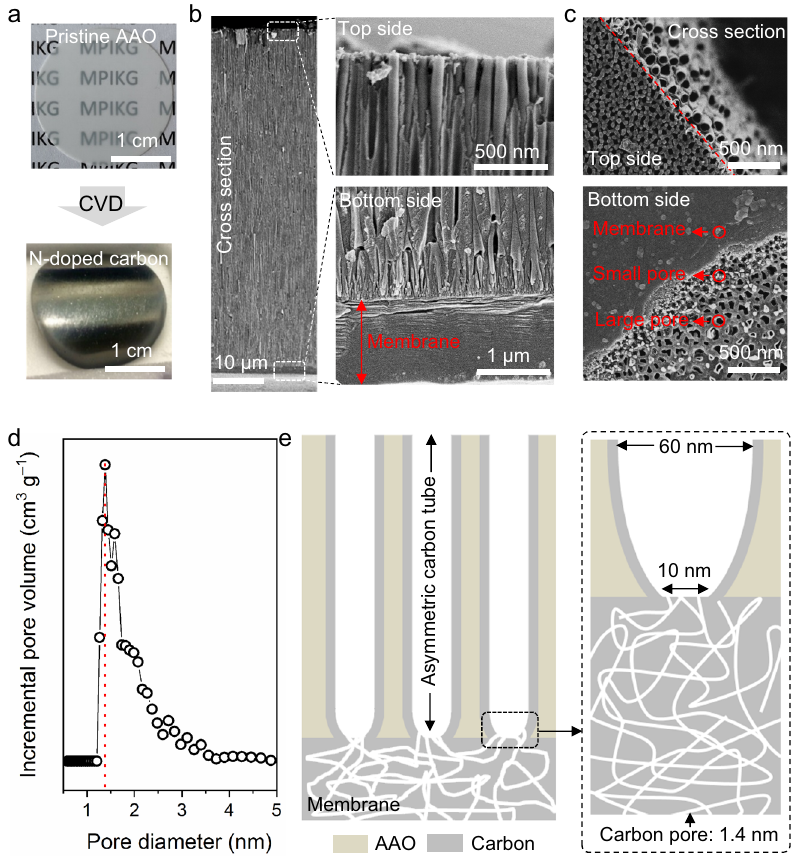
Fig. 1 Structure and ion transport properties of CMHPA. a Optical images of the AAO membrane before and after deposition of carbon, scale bar 1 cm. b Cross-section of CMHPA and typical opening view of the nanotube side and membrane side. c Top view of the nanotube side and bottom view of the membrane side. d Pore size distribution of the membrane segment. The diameter distribution peak is found at 1.4 nm. e Scheme illustrating CMHPA with a pore gradient: the nanotube diameter gradually changes from 60 to 10 nm, and the pore size in the membrane segment is ∼ 1.4